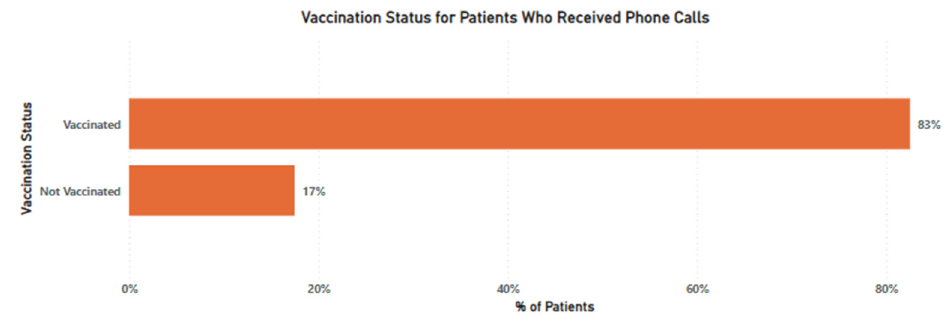
Figure 3. Self-reported vaccination status for participants reached through phone calls.